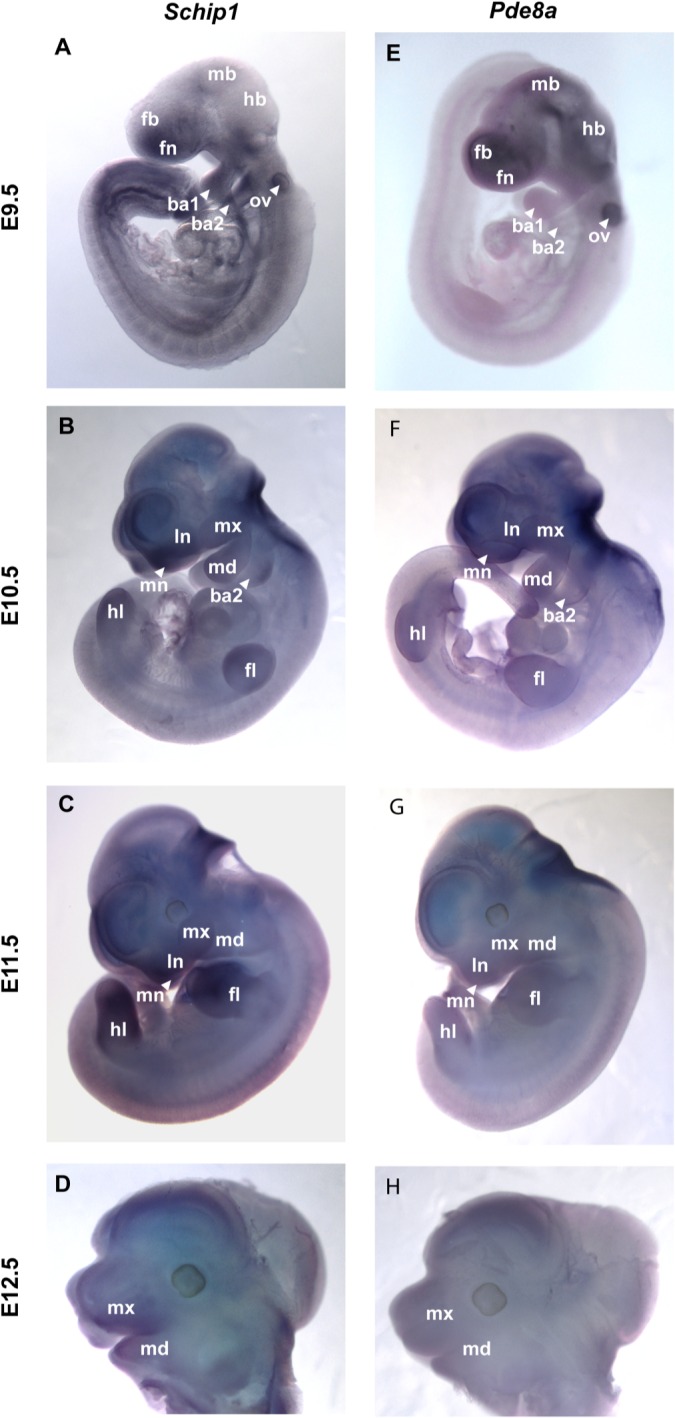
Expression of Schip1 and Pde8a during mouse embryonic development.Whole-mount in situ hybridization of (A-D)
Schip1 and (E-H)
Pde8a expression in mouse embryos from E9.5 to E12.5. ba1, first branchial arch (future mandible); ba2, second branchial arch; fb, forebrain; fn, frontonasal process; fl, forelimb; hb, hindbrain; hl, hindlimb; ln, lateronasal process; mb, midbrain; md, mandible; mn, medionasal process; mx, maxilla; ov, otic vesicle.